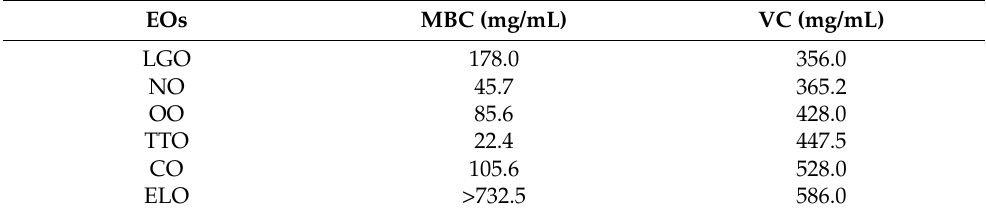
Table 2. MBCs and VCs of selected EOs against the bacterium E. coli (host) and the bacteriophage MS2 ( n = 3, S.D. < ± 5.0 mg/mL). Listing of EOs was performed in descent order with respect to the acquired